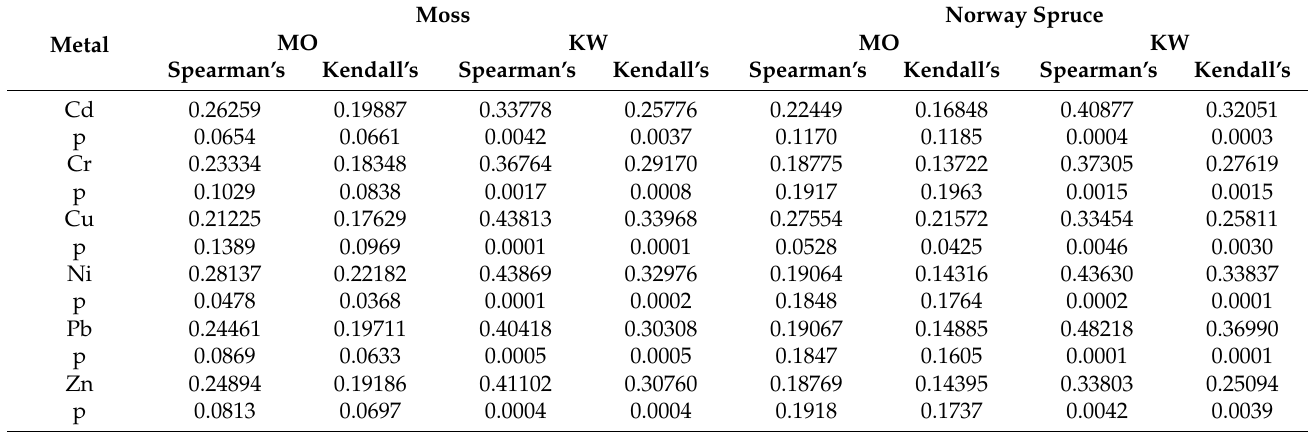
Table 4. Spearman’s and Kendall’s rank correlations for plants in the test areas (Kasprowy Wierch-KW and Morskie Oko-MO) in the Tatra National Park, Poland.